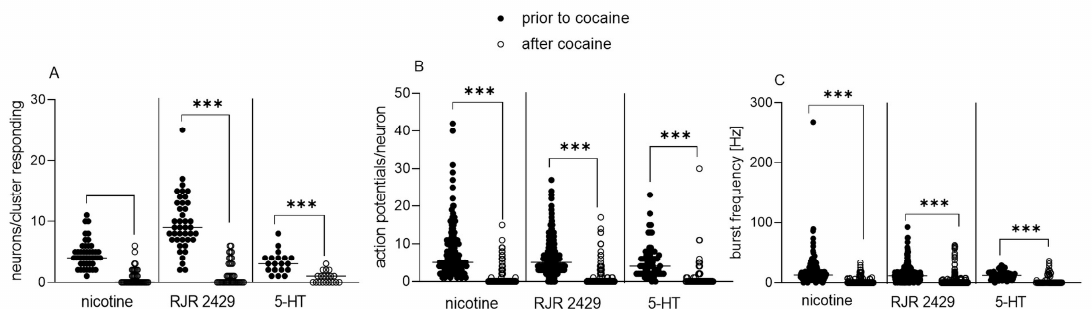
Figure 1. Effect of 30 min perfusion with cocaine on responses of cultured enteric neurons to nicotine, nicotine acetylcholine receptor (nAChR) agonist RJR 2429 and serotonin (5-HT) application. Perfusion of 14 d cultured enteric neurons with 10 µ M cocaine for 30 min resulted in a significantly reduced number of responding neurons/cluster ( A ), number of action potentials fired by each neuron ( B ) and burst frequency of action potential discharge ( C ) in response to nicotine (100 µ M), RJR 2429 (10 µ M) and 5-HT (1 mM) application, respectively. Horizontal lines within data points indicate median values; n = cultures/clusters (whereas each culture was derived from a single animal), nicotine n = 4/43, RJR 2429 n = 3/41, 5-HT n = 3/19. Wilcoxon test, *** p < 0.001.